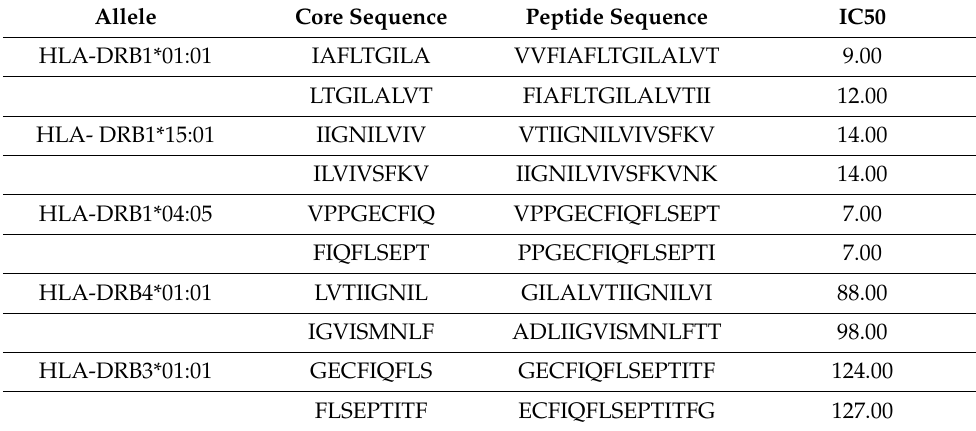
Table 12. Predicted peptides on risk alleles for human